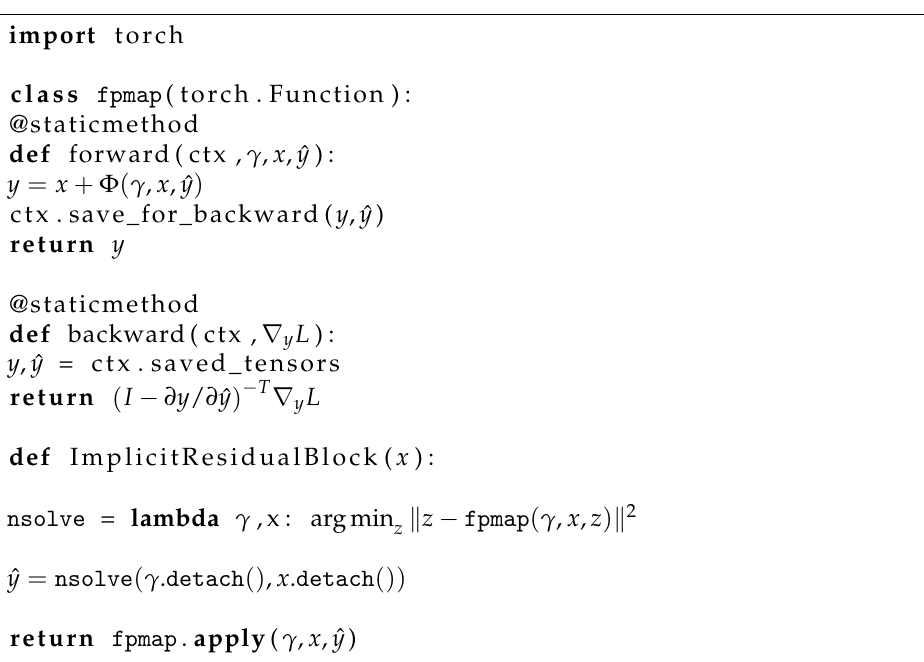
Figure 5. Forward and backward computational graphs of the implicit layer. Listing 1. PyTorch pseudocode of the implicit residual